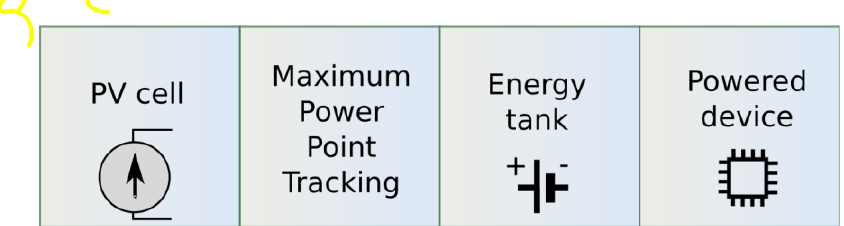
Figure 17. Block diagram of PV-based EH system.